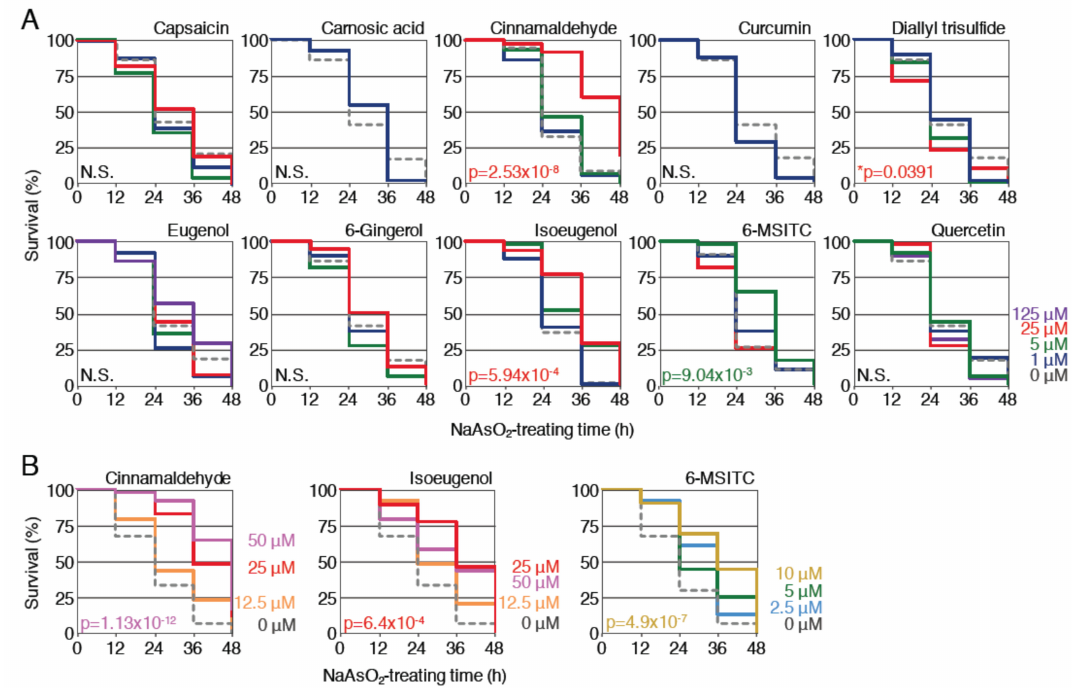
Figure 3. E ff ects of pretreatment with spice-derived phytochemicals on the survival rates of zebrafish larvae exposed to NaAsO 2 . ( A ) Survival assays using 10 phytochemicals at 4 concentrations. Larvae (3.5 dpf) were pretreated with indicated phytochemicals at concentrations of 0 µ M (gray, dotted), 1 µ M (dark blue), 5 µ M (green), 25 µ M (red) or 125 µ M (purple). After pretreatment for 12 h, the solution was changed to 1.9 mM NaAsO 2 and survival was measured every 12 h for 48 h. ( B ) Optimization of the phytochemical concentrations. Larvae (3.5 dpf) were pretreated with cinnamaldehyde (0 (gray, dotted), 12.5 (orange), 25 (red), 50 µ M (pink)), isoeugenol (0 (gray, dotted), 12.5 (orange), 25 (red), 50 µ M (pink)) or 6-MSITC (0 (gray, dotted), 2.5 (light blue), 5 (green), 10 µ M (yellow)) at the indicated concentrations. An asterisk denotes toxic e ff ects of the indicated